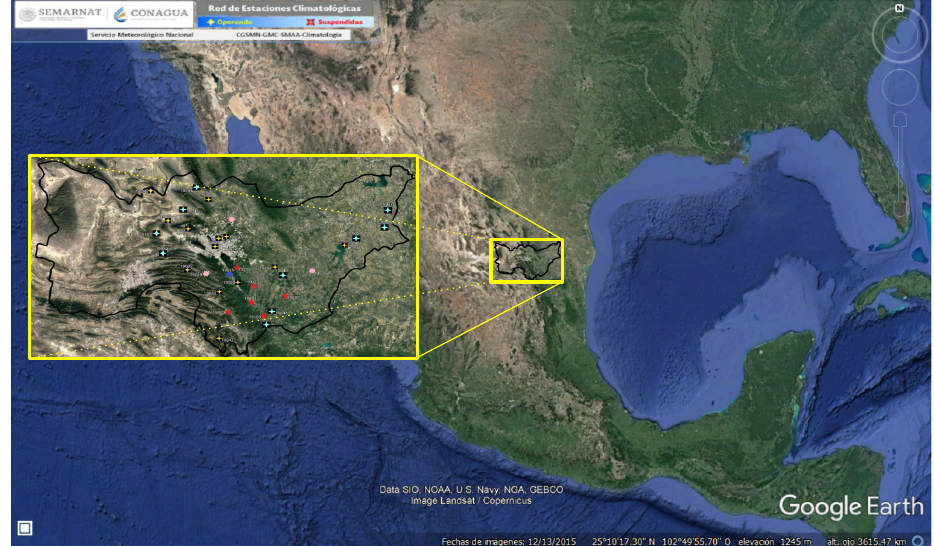
Figure 1. Location of the RH-24 México